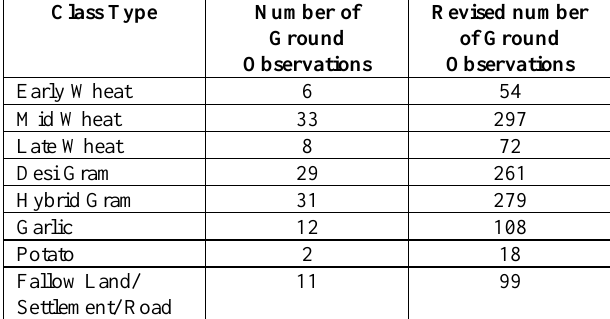
Figure 3. Random Forest Methodology